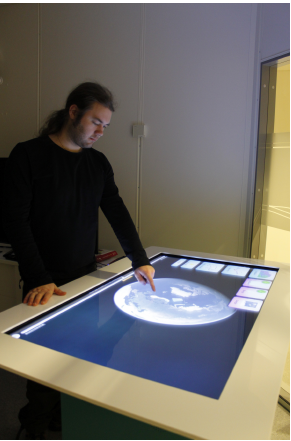
Figure 8: The visualization running on an Archimedes Exhibi- tions SessionDesk 2.0 multi-touch